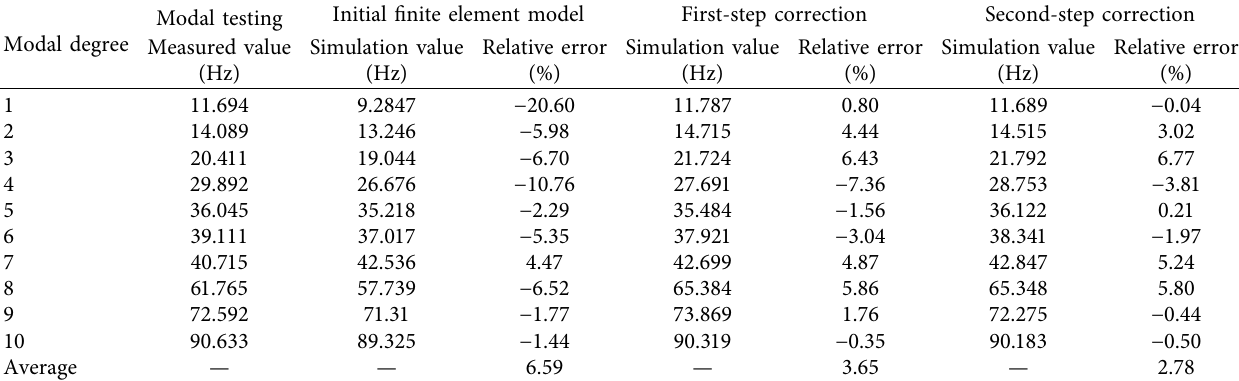
Table 4: Error comparison of the fnite element model modifed by the neural